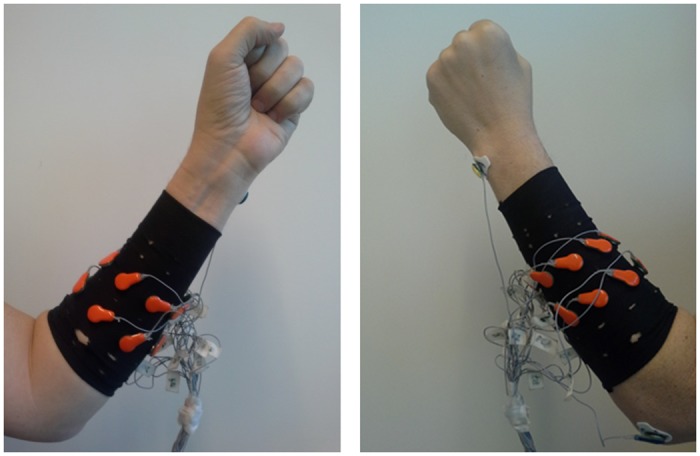
Forearm of a normally limbed subject wearing the textile hose including 16 electrodes.